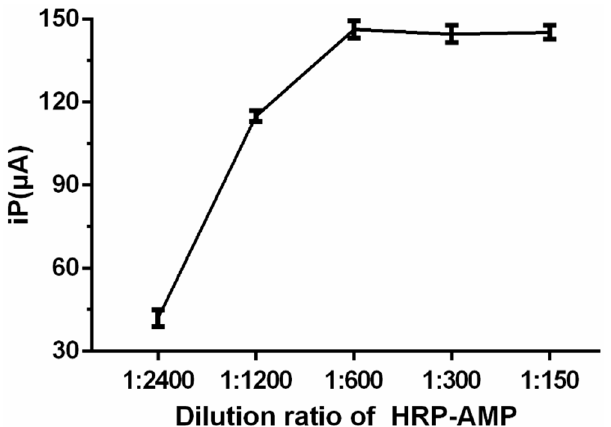
Figure 4. The CV peak current values of different mutation protein I188K/S19C/G24C concentrations.